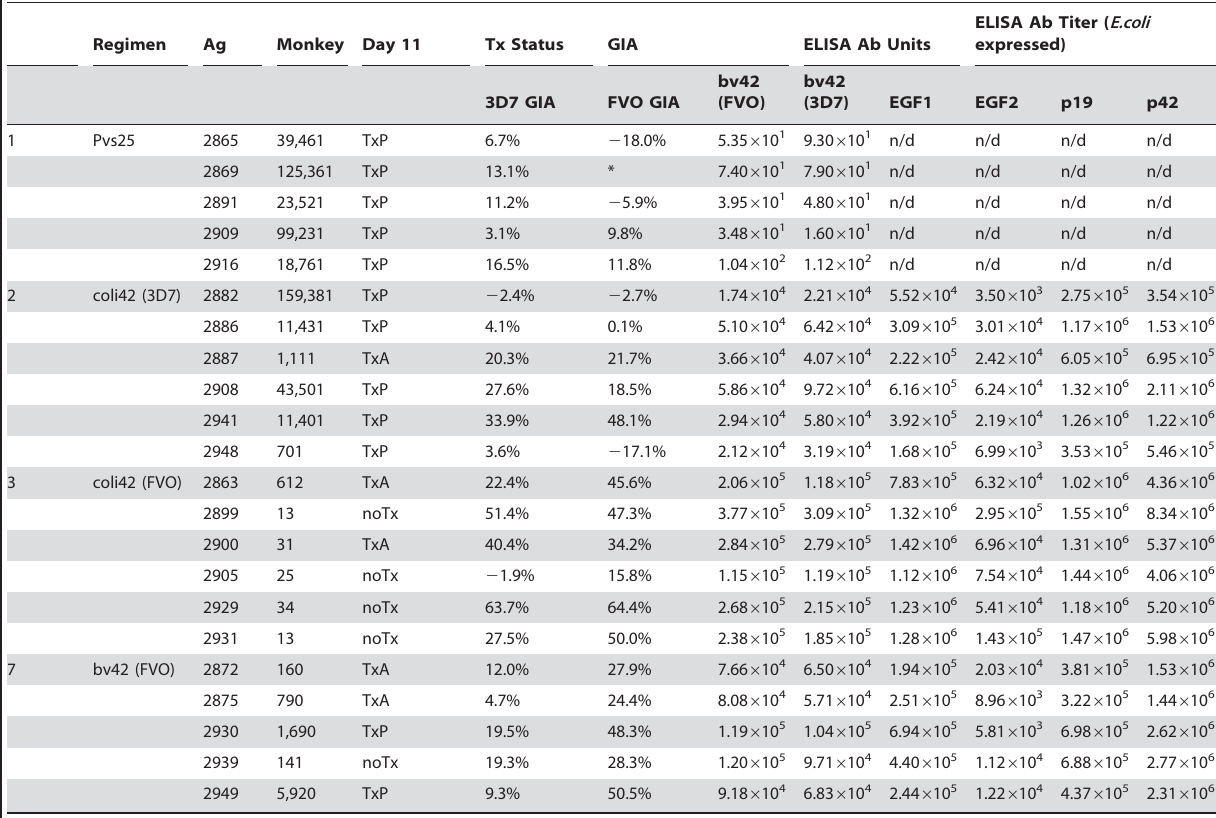
Table 1. Trial Design and Results for Adjuvant CFA/FA